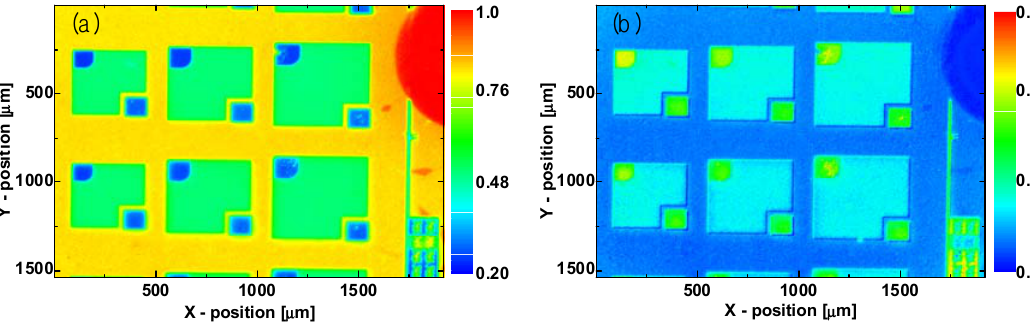
Figure 6. ( a ) Emissivity map and ( b ) relative reflected radiation ( I